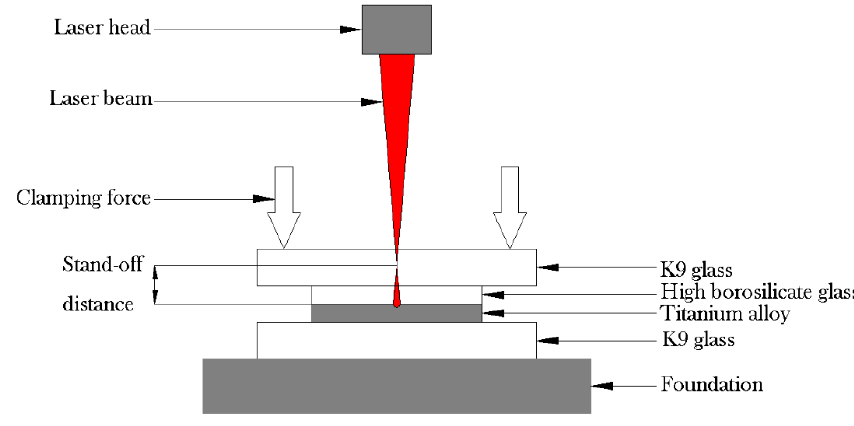
Figure 1. Laser transmission welding schematic. Table 5. Process parameters and limits for laser transmission welding.